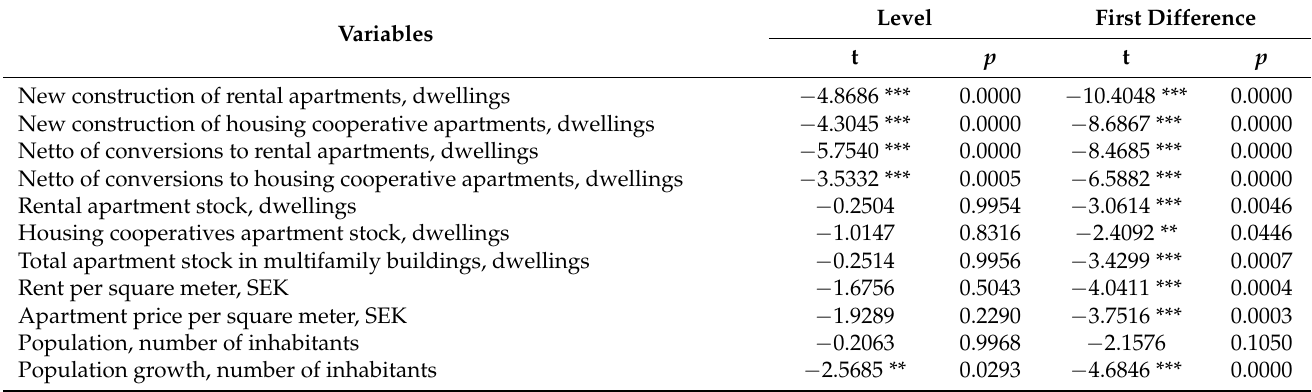
Table A3. Stationarity test for